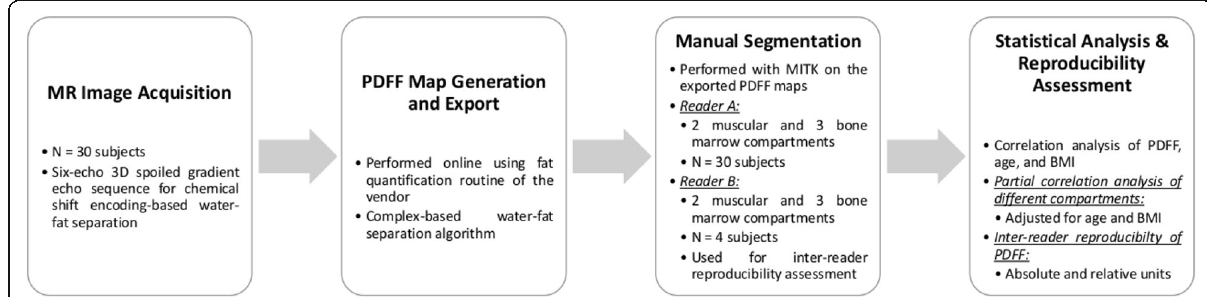
Fig. 1 Overview of the image acquisition, postprocessing workflow, and image data analyses. BMI, Body mass index; PDFF , Proton density fat